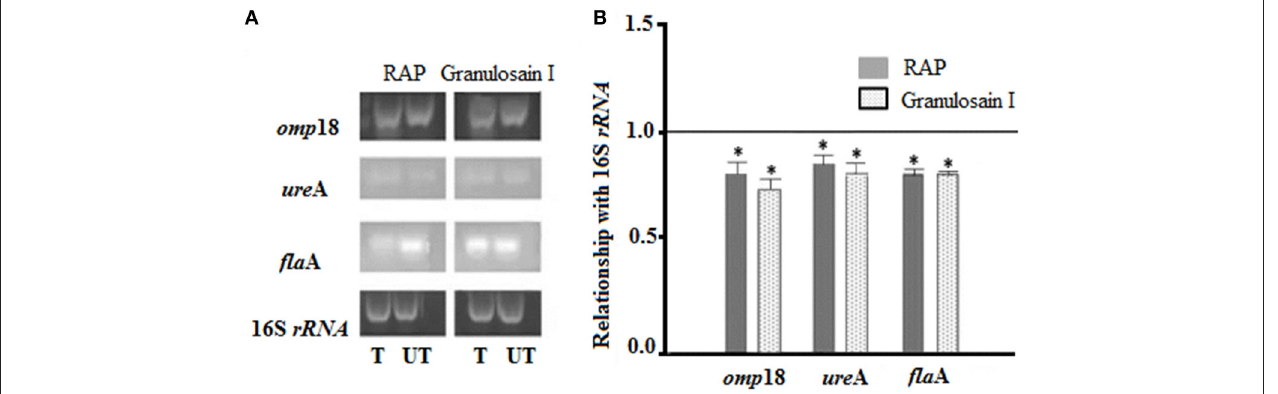
FIGURE 2 | (A) Electrophoretic gels: Helicobacter pylori amplicons resulting from RT-PCR in 1.8% agarose gels stained with Gel Red ® . (T) Treated cultures and (UT) untreated cultures of H. pylori with the partially purified proteolytic extract (RAP) of the fruits of Solanum granuloso-leprosum and granulosain I. (B) Relative quantification of the expression of the H. pylori pathogenic factors, before and after treating H. pylori cultures with RAP and granulosain I. *Represents significant differences ( p ≤ 0.05) with respect to 16S rRNA , according to the Student’s t